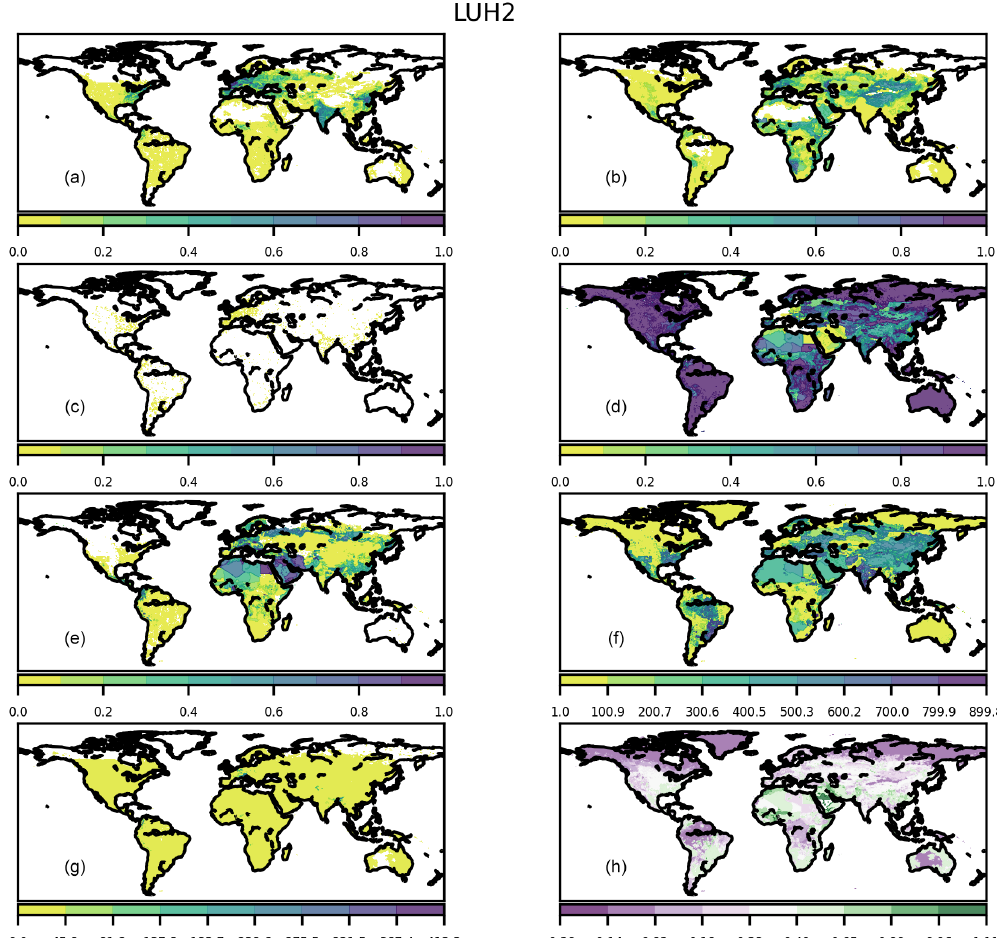
Figure 9. Maps for the year 1850 showing the following: (a) the fraction of each grid cell occupied by cropland; (b) the fraction of each grid cell occupied by pasture; (c) the fraction of each grid cell occupied by urban land; (d) the fraction of each grid cell occupied by primary vegetation; (e) the fraction of each grid cell occupied by secondary vegetation; (f) the mean age (in years) of secondary lands in each half-degree grid cell; (g) the mean gross transitions (km 2 yr − 1 ) over a 20-year interval for each grid cell; and (h) the mean net transitions (km 2 yr − 1 ) over a 20-year interval for each grid